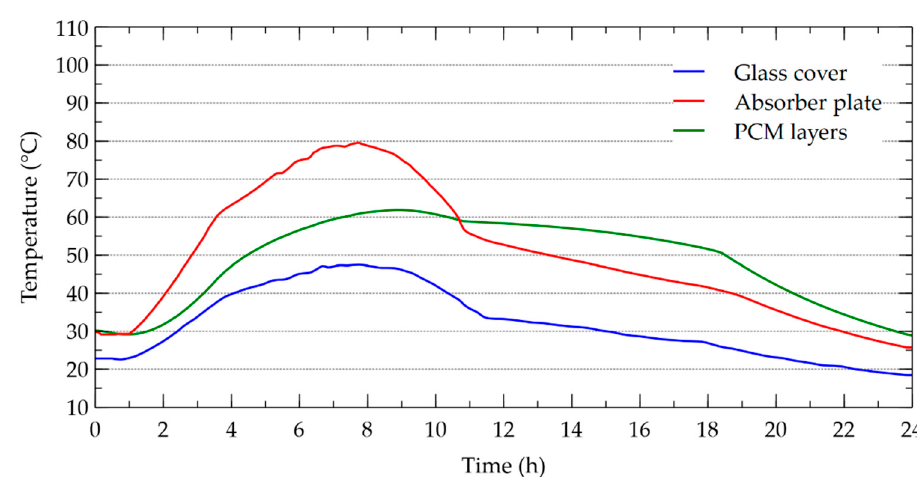
Figure 10. Estimated temperatures of components in case 2.